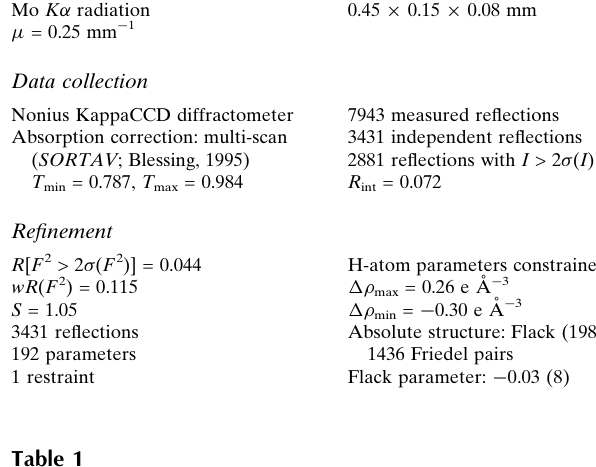
Hydrogen-bond geometry (A˚ , (cid:3)